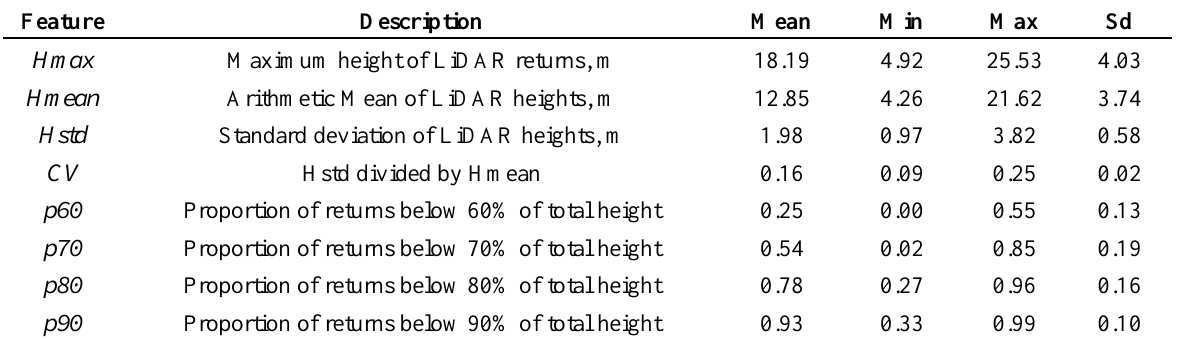
Table 2. Statistics of the extracted Light Detection And Ranging (LiDAR)